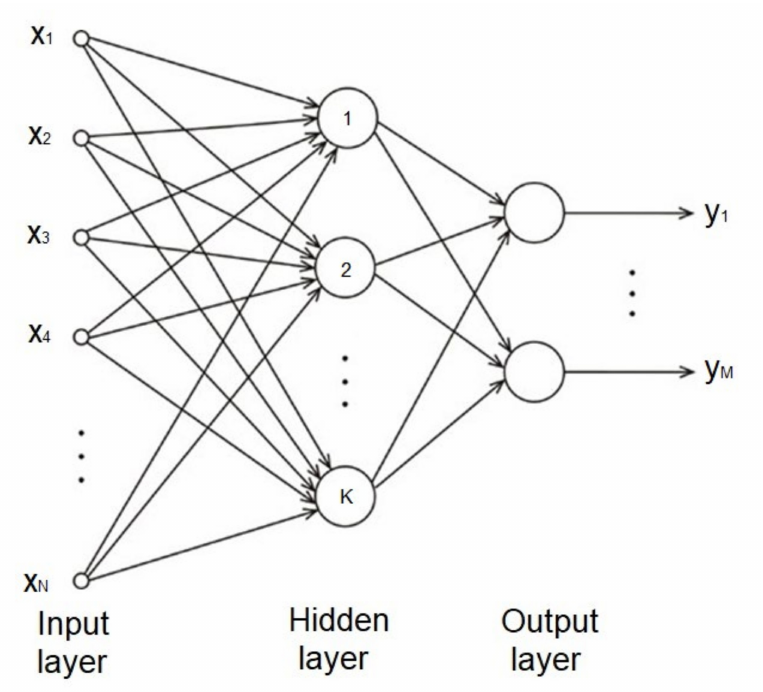
Figure 3. A simplified diagram of a unidirectional neural network with one hidden